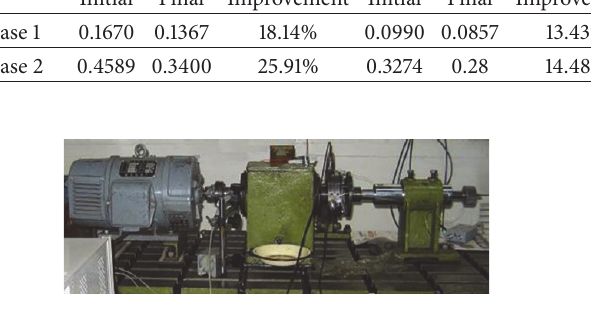
Figure 5: Test rig of Case